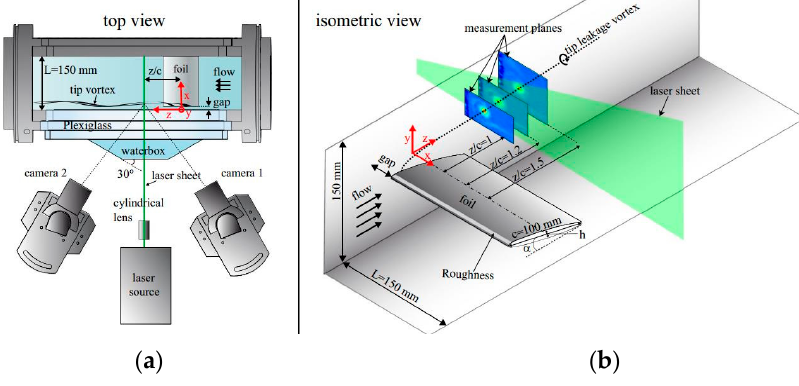
Figure 6. Sketch of the SPIV instrument. ( a ) top view; ( b ) isometric view [14].